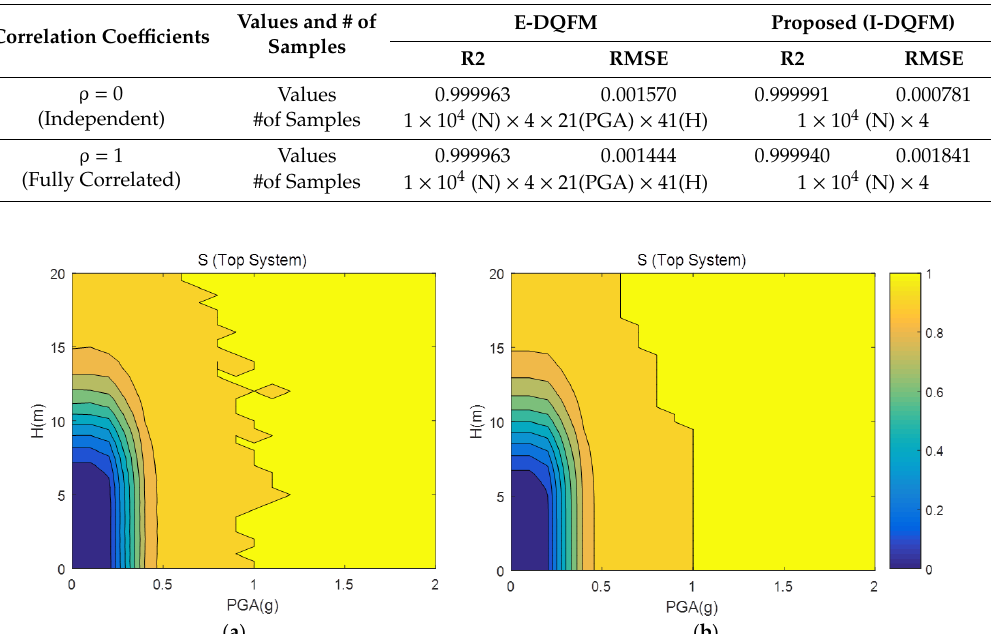
( d ) Figure 11. R 2 and RMSE comparison of E-DQFM and proposed method according to the number of samplings “N” regarding (C1 ∪ C2) ∩ C3 example: ( a ) R 2 for independent case; ( b ) RMSE for independent case; ( c ) R 2 for fully correlated case; ( d ) RMSE for the fully correlated case.